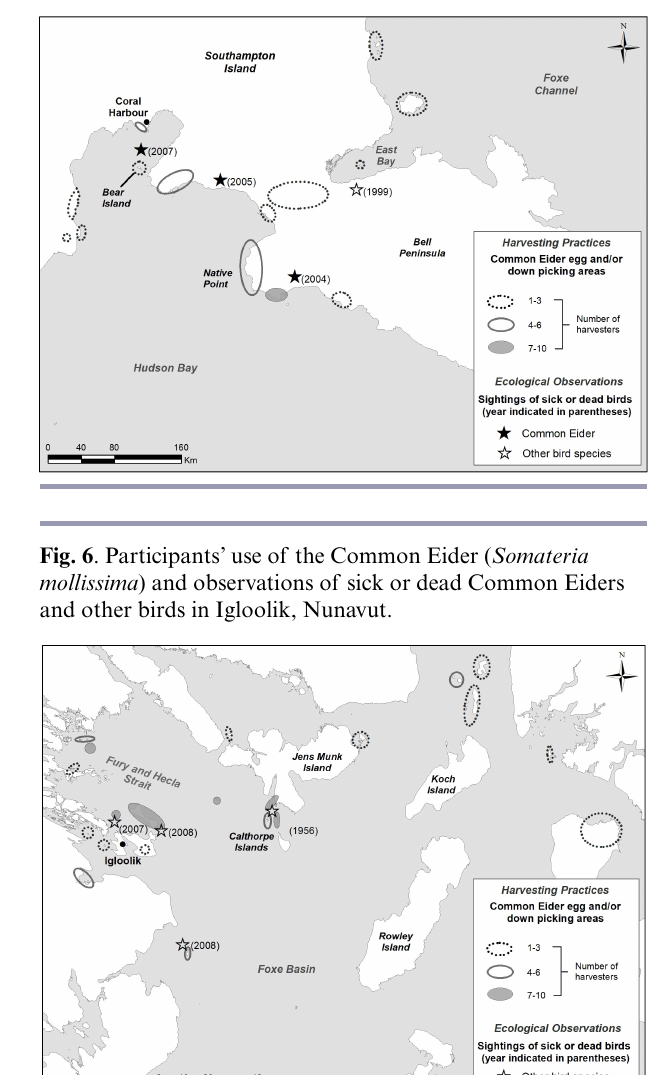
Fig. 5 . Participants’ use of the Common Eider ( Somateria mollissima ) and observations of sick or dead Common Eiders and other birds in Coral Harbour, Nunavut.